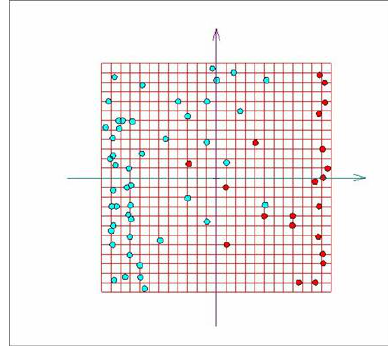
Figure 9. Extension of elastic map for classes car, fad+.